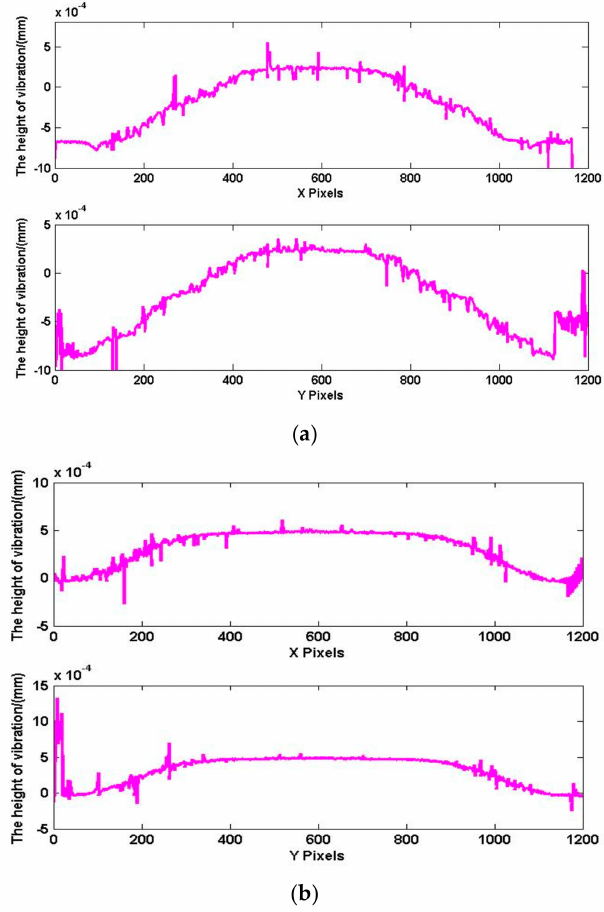
Figure 16. Data comparison at t 1 and t 2 moment. ( a ) Maximum surface topography at t 1 moment; ( b ) the surface topography at t 2 moment.